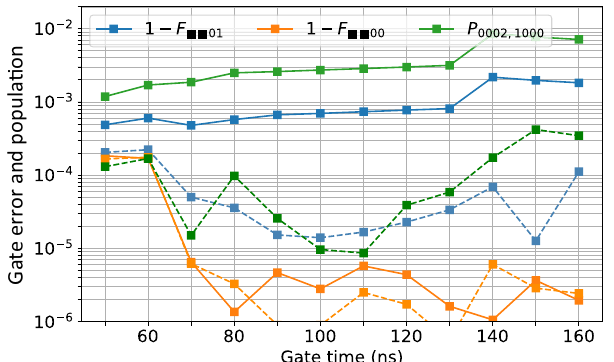
FIG. 12. Isolated CZ 01 gate error with the other two nonpartici- pating qubits in two different state configurations, i.e., 1 − F (cid:2)(cid:2) 00 and 1 − F (cid:2)(cid:2) 01 , as a function of gate time. P 0002,1000 denotes the population leakage to state | 0002, 1000 (cid:2) with the four-qubit square system initialized in state | 1101, 0000 (cid:2) . Solid lines and dashed lines denote the result with qubit anharmonicity η Q / 2 π = / 2 π = − 310 MHz, respectively. The other − 300 MHz and η Q system parameters used here are the same as in Fig.